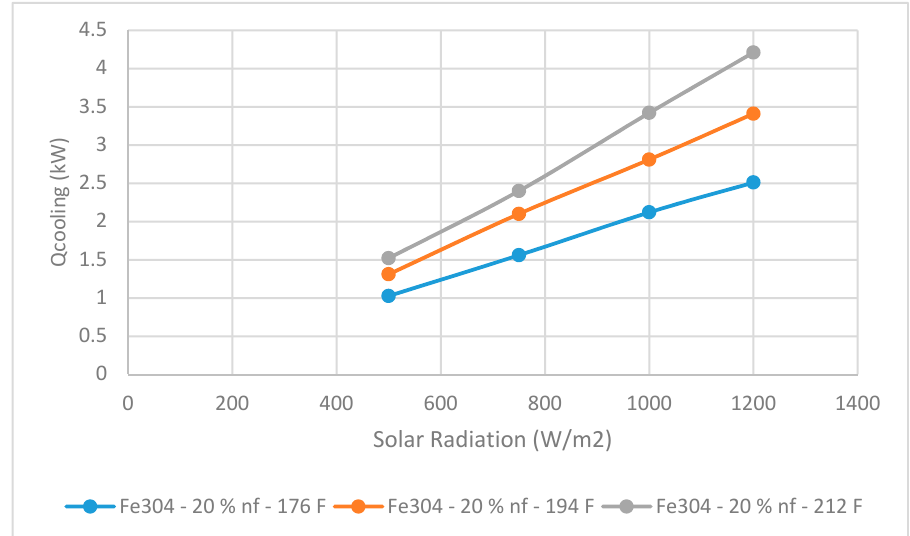
Figure 12. Cooling load effect produced with Fe 3 O 4 at different temperatures.